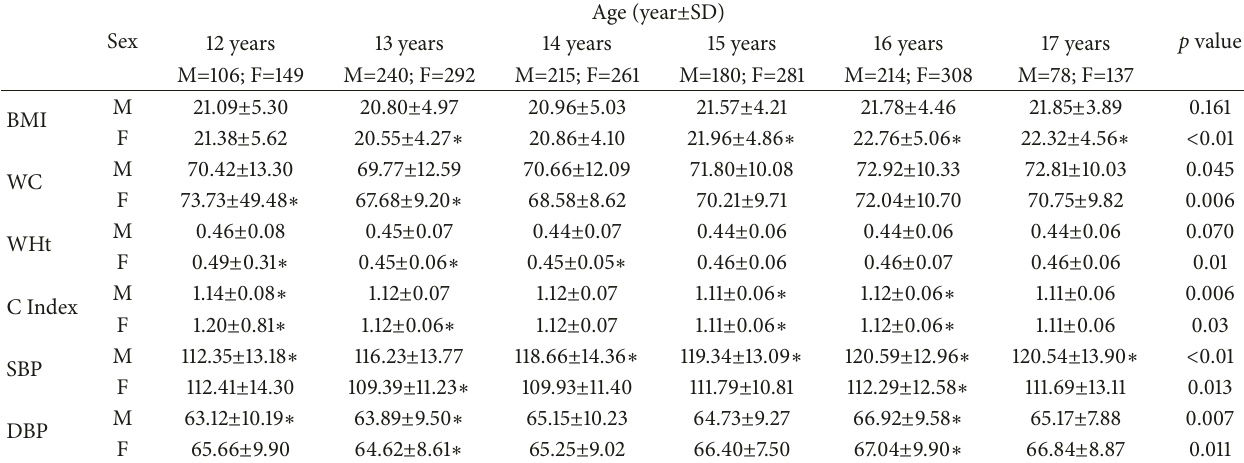
Table 2: Anthropometric measurement and blood pressure according to age among male and female respondents